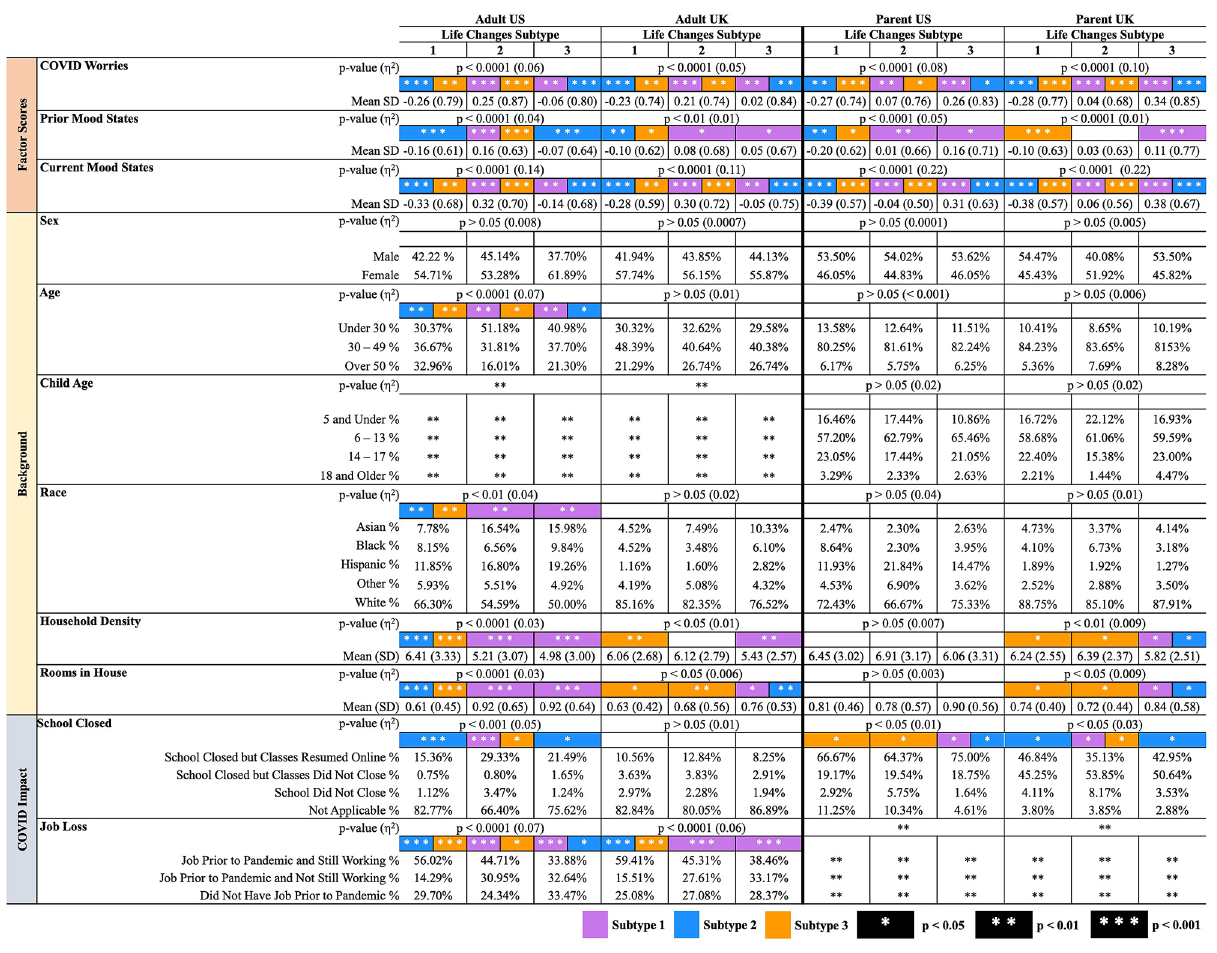
Figure 2. Mean factor scores, demographic characteristics, and pandemic-related school closure and job loss by Life Changes subtypes. Color indicates that the group in a given column is significantly different from the subtype of the indicated color. Pairwise group differences are represented by white asterisks: * p < 0.05, ** p < 0.01, *** p <